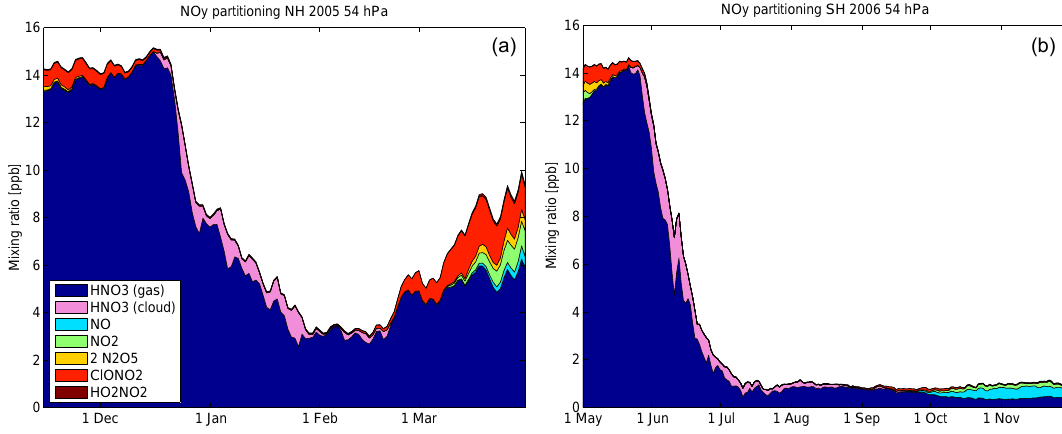
Figure 2. Vortex-averaged partitioning of NO y species for the Arctic winter 2004–2005 (a) and the Antarctic winter 2006 (b) at 54hPa. Species NO 3 , BrONO 2 , ClNO 2 and N are not shown due to their small mixing ratios.